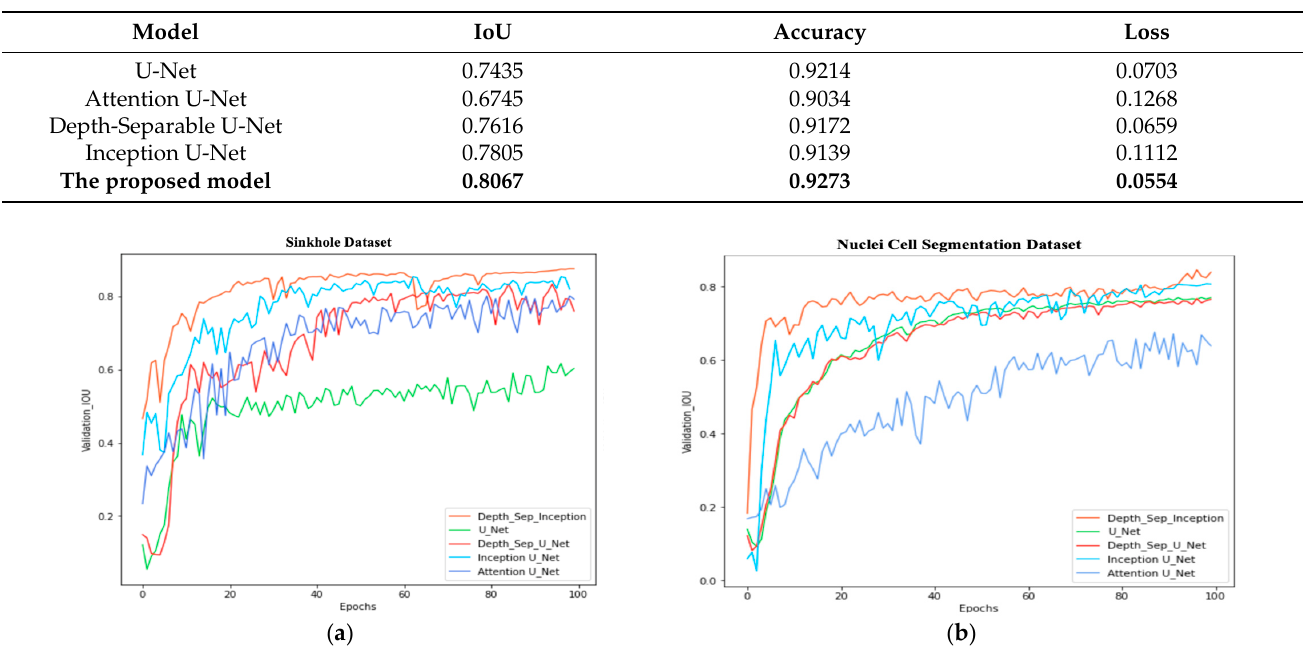
Figure 9. Validation graphs of the segmentation models: ( a ) the IoU validation graph of the sinkhole dataset graph; and ( b ) the IoU validation graph of the Data Science Bowl dataset for nuclei cell segmentation. The proposed, depth-wise separable U-Net in the orange color shows the highest validation IoU compared to the other models.